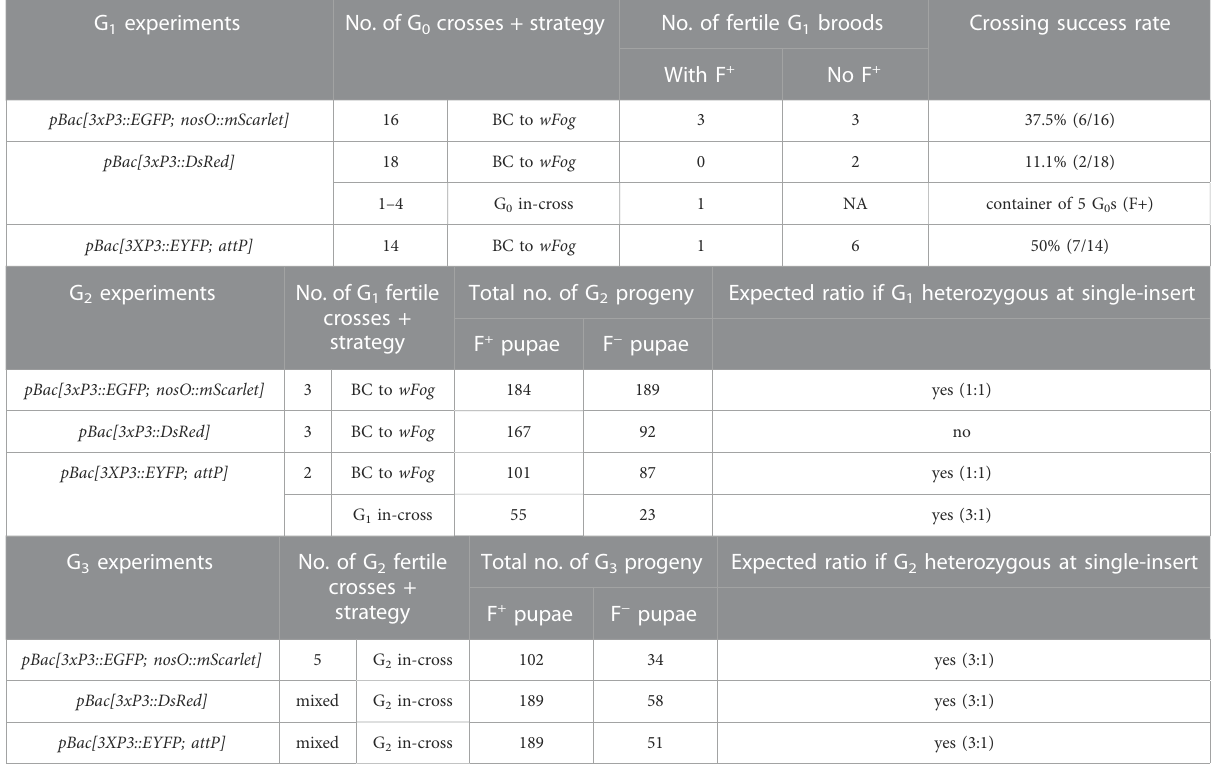
TABLE 2 Subsequent crossing of transgenic Plodia G 0 founders. No. of G 0 crosses + strategy No. of fertile G 1